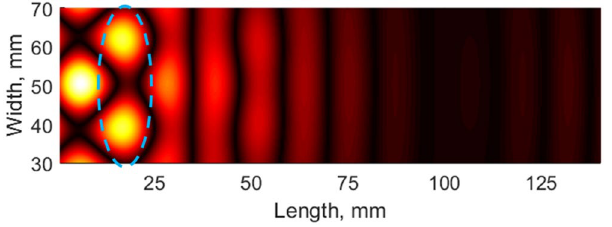
Figure 8. Simulation results showing the imaging of the defects in subwavelength regime on Molybdenum side of the material contrast